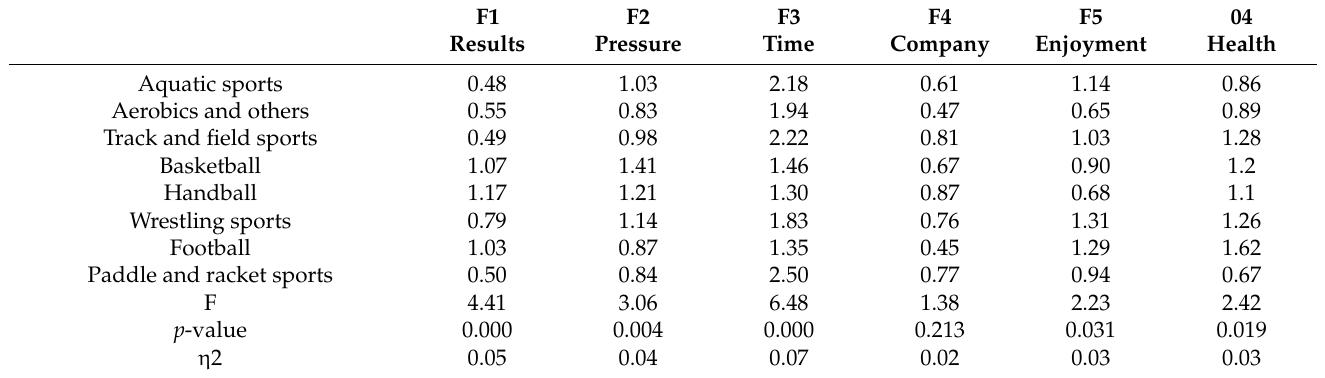
Table 6. Dropout reasons based on the type of sports